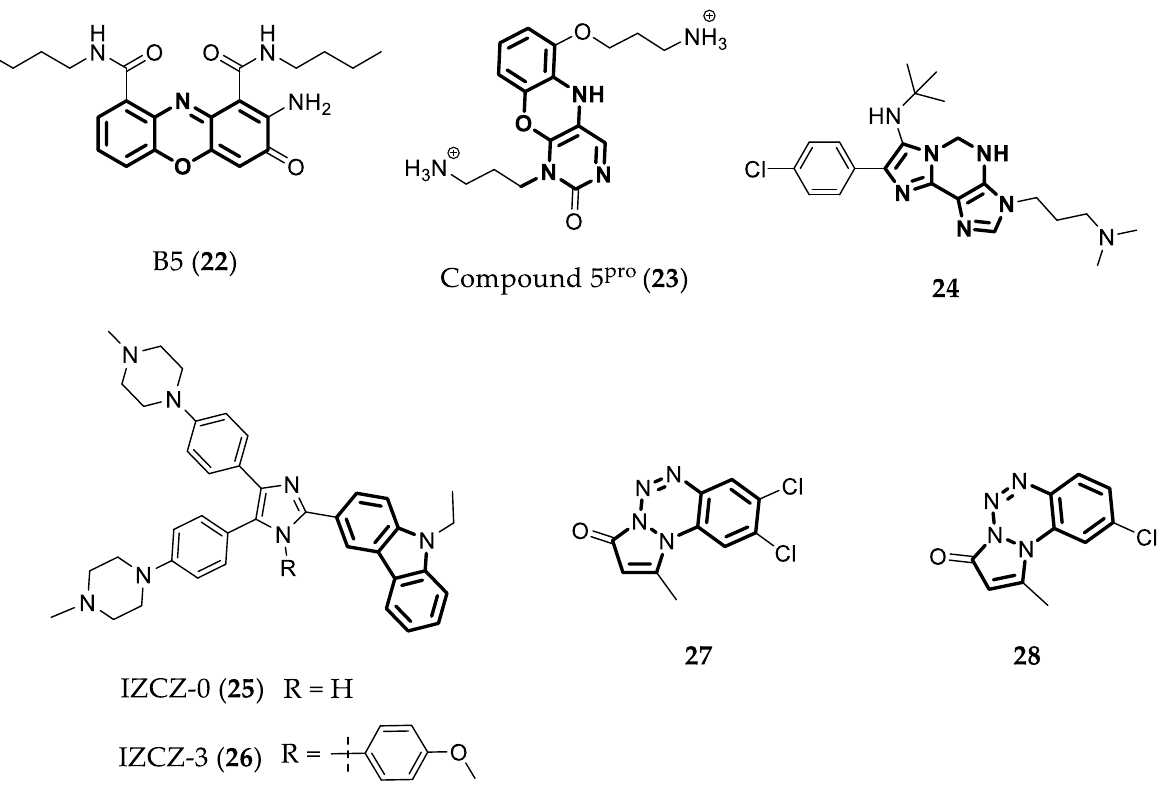
Figure 8. Structures of c-MYC G4 ligands with three fused aromatic rings.